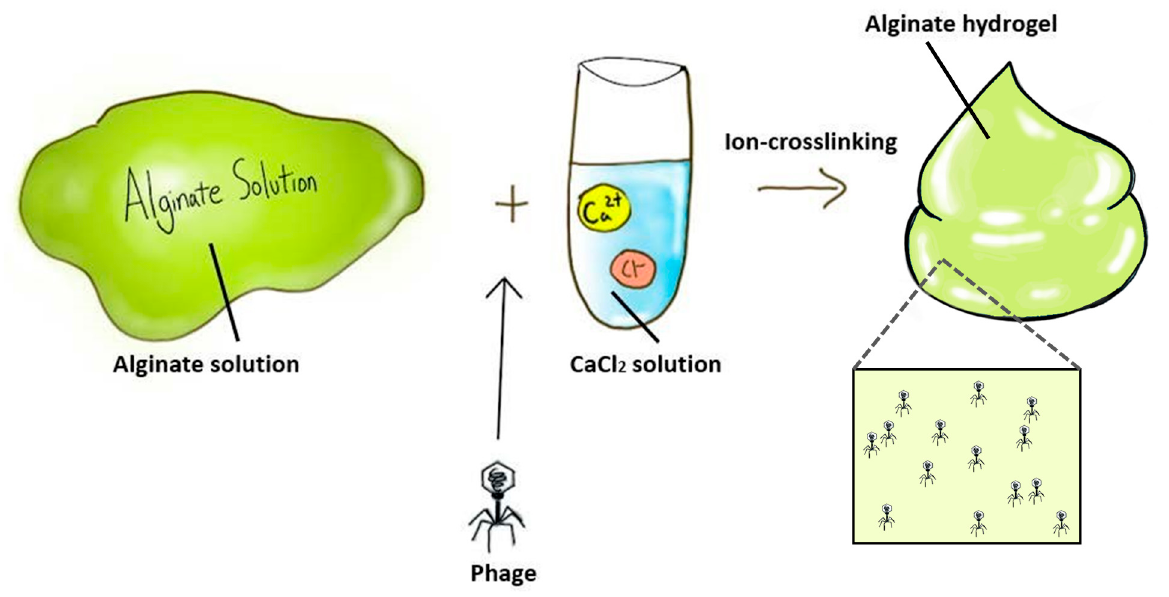
Figure 1. Preparation of phage-delivering alginate hydrogel formulation.